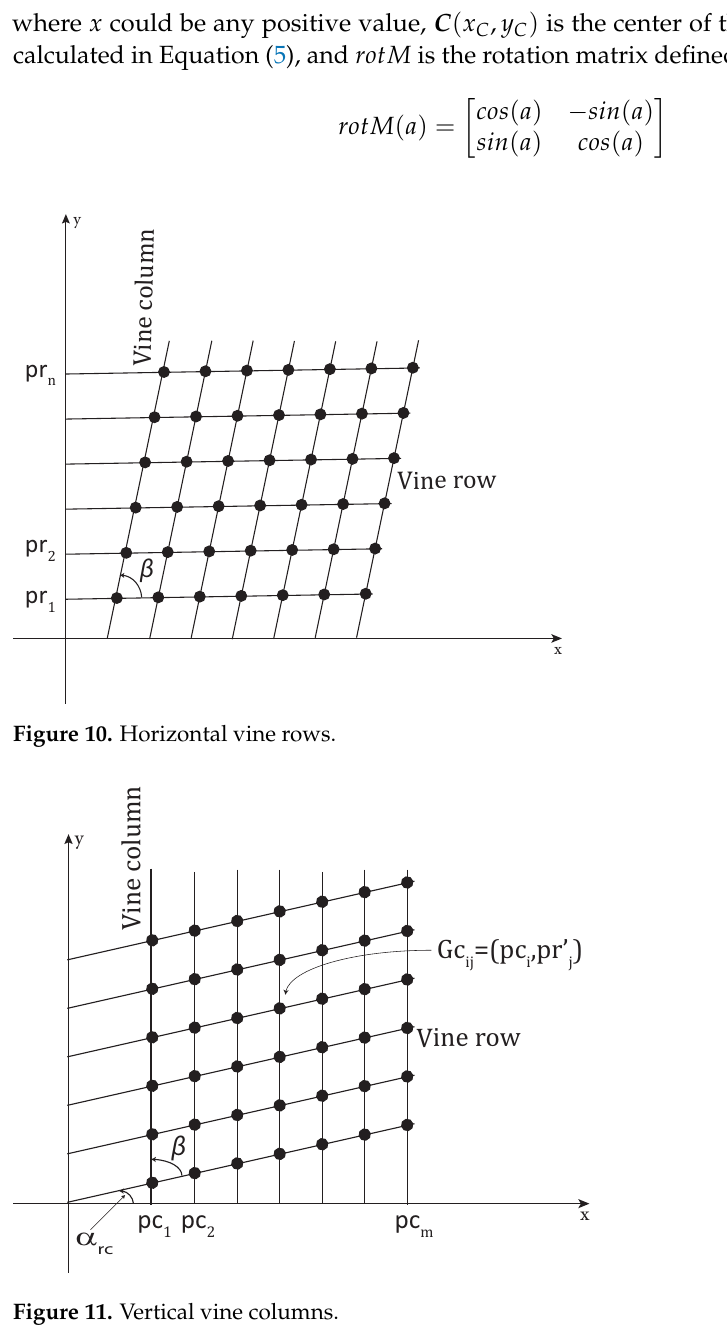
Figure 11. Vertical vine columns. In the case of Parcel 59B, β = 180° − 56° − 35.5° = 88.5° and α rc = 90° − 88.5° = 1.5°. The grid points displayed over the BW c image represent either a living vine point, a missing vine point or a bare point. Points having their red, green, and blue components equal to 0 belong to the no-data segment; they are considered as bare points and, therefore, discarded. For all remaining points, a rectangle window, centered on the considered point, is cropped from the BW c image. The length and width of the rectangle are equal to half